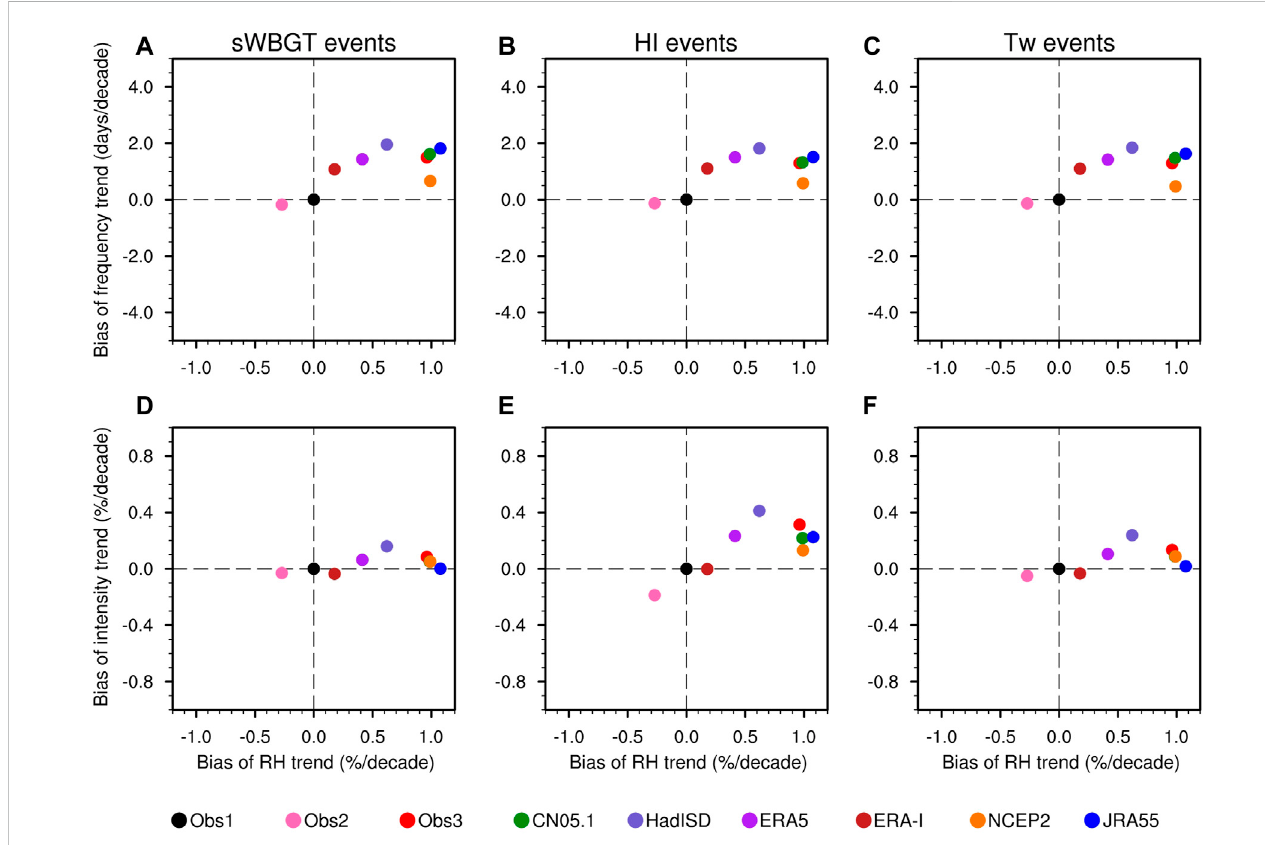
FIGURE 4 Scatter plot – between regional-mean (southeast China) RH trend bias and extreme events ’ frequency (A – C) /intensity (D – F) trend bias, amongst inhomogeneous datasets with reference to homogenized one (OBS-1, black dot in the